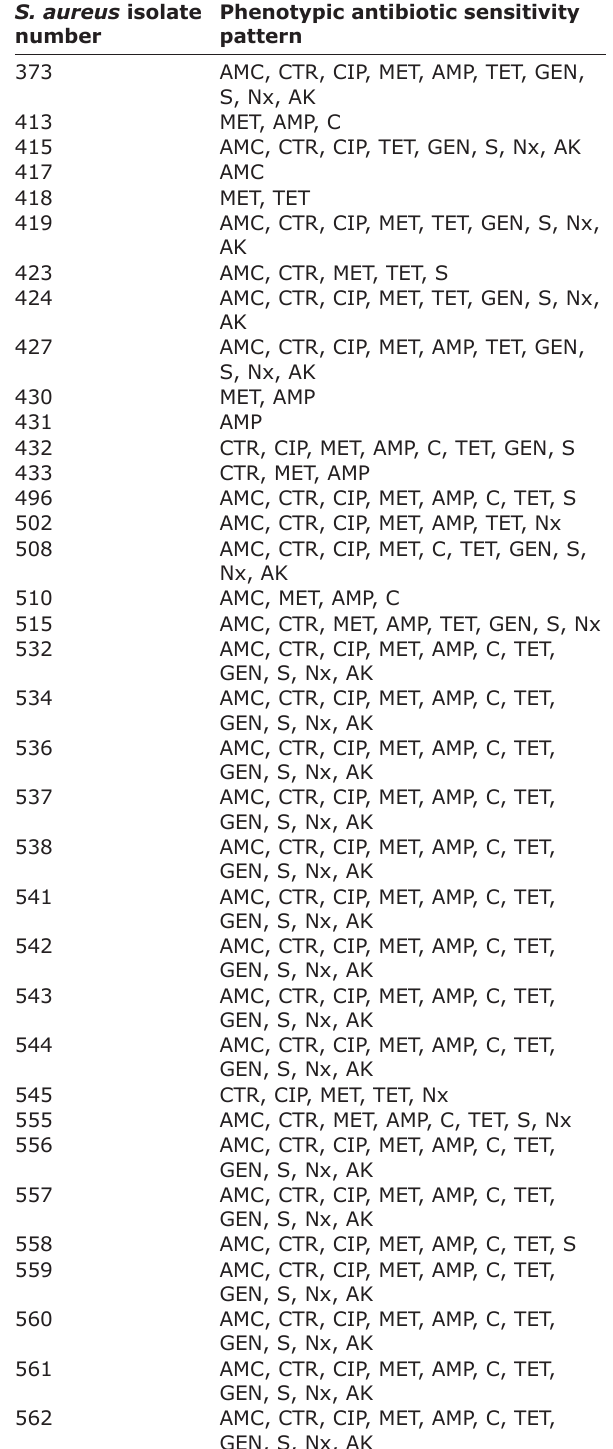
Table-3: Phenotypic antibiotic resistance pattern of S. aureus isolates from various clinical samples using 11 commonly used antibiotics in veterinary field conditions by Kirby–Bauer disc diffusion method. S. aureus isolate